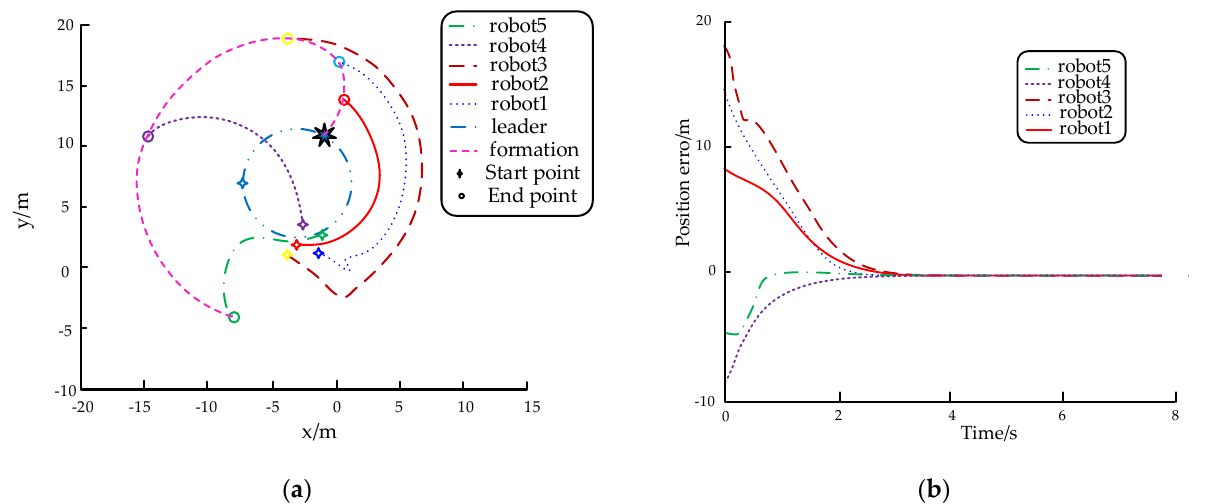
Figure 13. ( a ) Trajectories of nine robots on the plane by PFC in spiral formation; ( b ) Formation position error of each following robot.